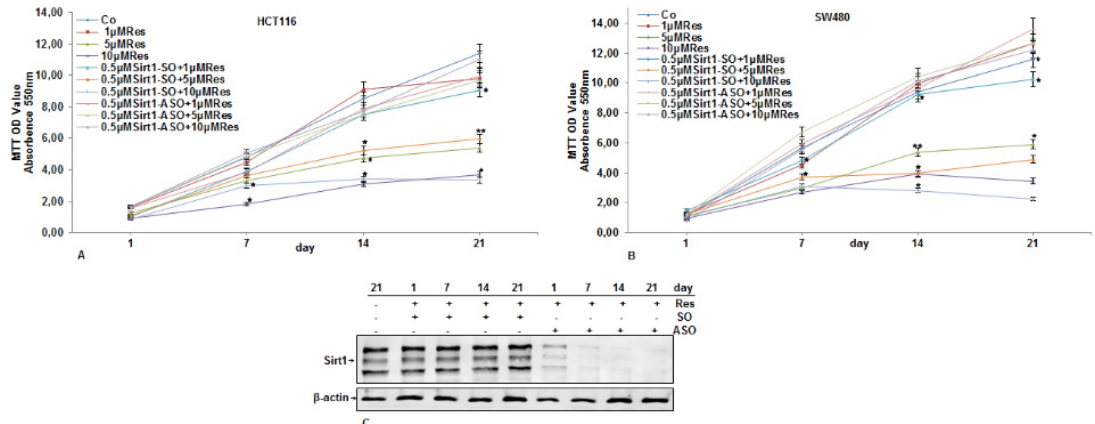
Figure 2. Effects of resveratrol and Sirt1 ‐ ASO on the proliferation of CRC cells in alginate culture. Serum ‐ starved HCT116 ( A ) and SW480 ( B ) cell lines in alginate culture (1 × 10 6 /mL) were either left untreated, or treated with different concentrations of resveratrol alone (1, 5, 10 μ M), or transfected with 0.5 μ M sense oligonucleotide (SO) control, or antisense oligonucleotides (ASO) against Sirt1 in the presence of Lipofectin transfection reagent (10 μ L/mL) and co ‐ treated with different concentrations of resveratrol (1, 5, 10 μ M) for 21 days in alginate cultures, and cell viability was measured using the MTT method. The results are provided as mean values with standard deviations from at least three independent experiments. Values were compared to the control, and statistically ‐ significant values with p < 0.05 are designated by an asterisk (*); p < 0.01 designated by two asterisks (**); ( C ) Effects of Sirt1 ‐ ASO on Sirt1 expression in CRC cells in alginate culture. Serum ‐ starved HCT116 cells in alginate culture were either left untreated or transfected with 0.5 μ M sense oligonucleotide (SO) control or antisense oligonucleotides (ASO) against Sirt1 in the presence of Lipofectin transfection reagent (10 μ L/mL) and co ‐ treated with resveratrol (5 μ M) for 21 days. Whole cell lysates were prepared and analyzed by Western blotting with antibodies against Sirt1. Housekeeping protein β‐ actin served as a loading control in all experiments.